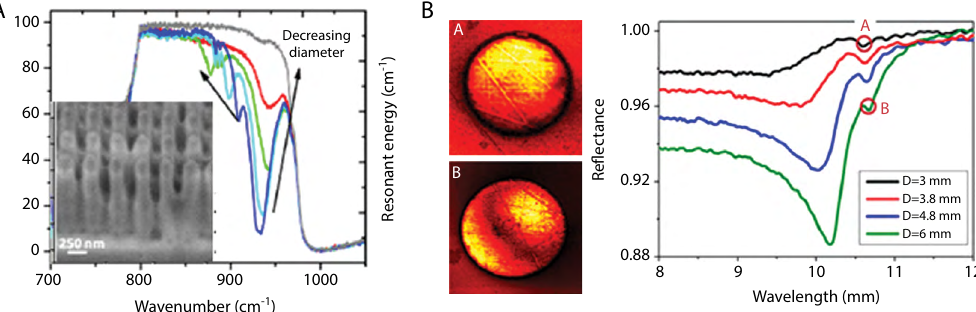
Figure 6 (A) Experimental FTIR reflection spectra of localized SPhP resonances in periodic arrays of 6H-SiC nanopillar arrays with varying diameters. Inset: SEM micrograph of representative nanopillar array. (B) SNOM images of SiC through circular gold apertures and the corresponding FTIR reflection spectra. Reproduced with permission from Ref. [23] (A) and [64]